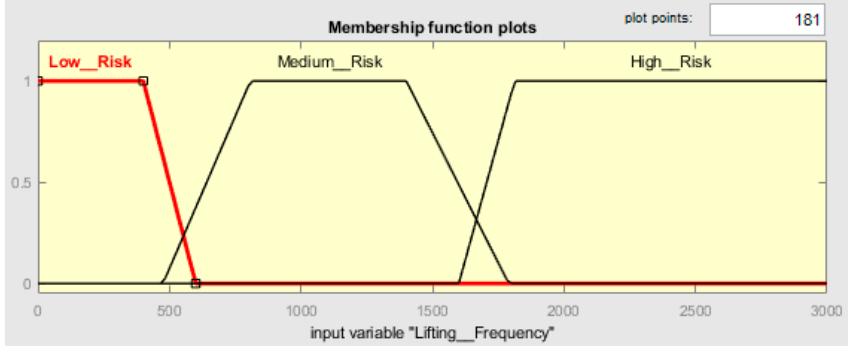
Figure 6. Membership function plots of Lifting_Frequency. Table 7. Ranges of frequency of lifting and their fuzzy sets.